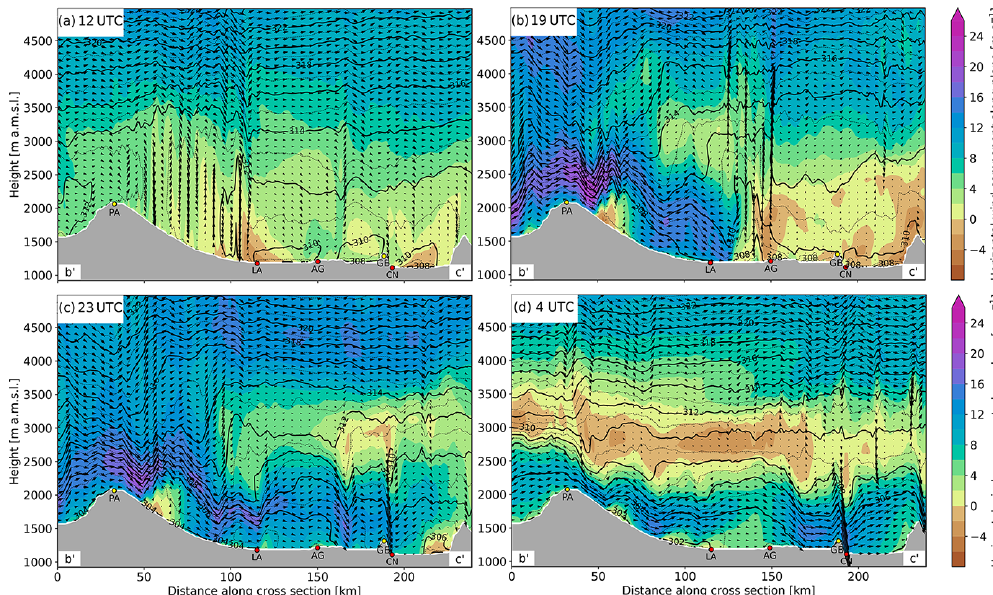
Figure 6. WRF simulation (domain d02) of the north-eastern gap flow: vertical transect along line b (cid:48) –c (cid:48) (see Fig. 1b) south of the pass (at 30km) around Lake Abaya and Lake Chamo at (a) 12:00UTC, (b) 19:00UTC, and (c) 23:00UTC 14 January 2020 and (d) 04:00UTC 15 January 2020. Shown is the potential temperature (black contour lines, 1K increments), the horizontal wind component along the transect (colour contours, 2ms − 1 increments), and arrows for the 2D wind field on the vertical plane. The pass (PA) and the northern edge of Lake Abaya (LA), AWS Alge (AG), God’s Bridge (GB), and AWS Chamo North (CN) are marked with black dots. Grey shading represents the